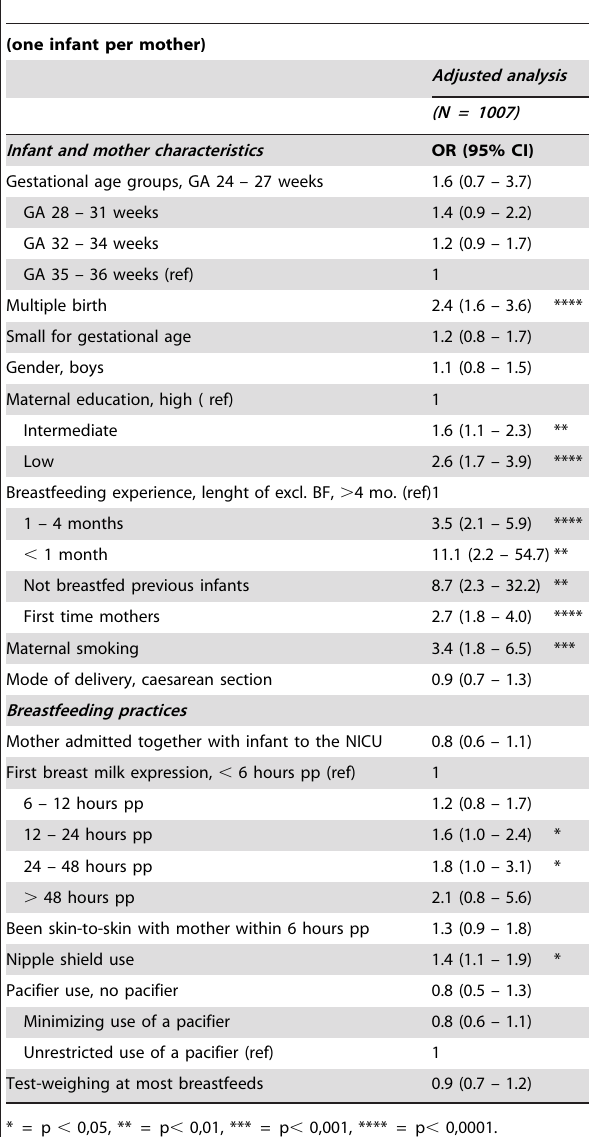
Table 4. Odds for inadequate duration of exclusive